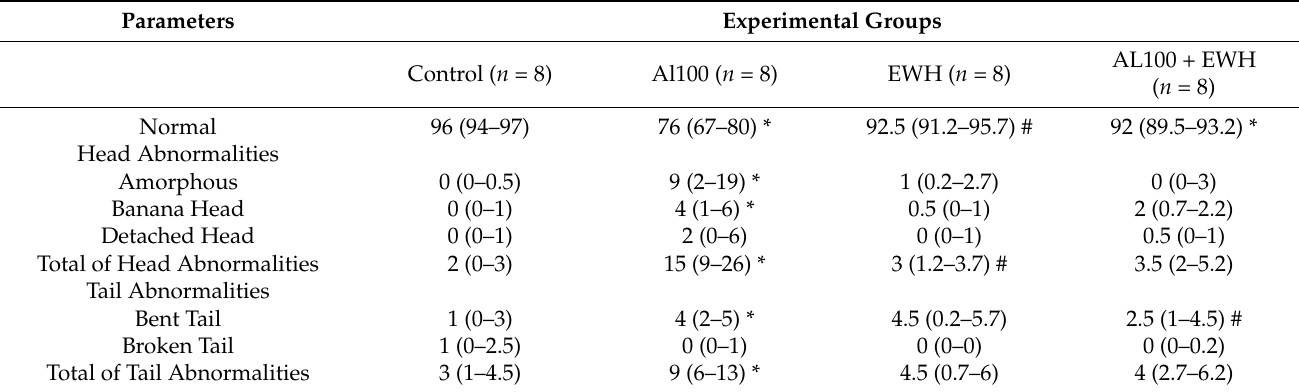
Table 6. Effect of EWH on sperm morphology of rats exposed to AlCl 3 at 100 mg/kg for 42 days.